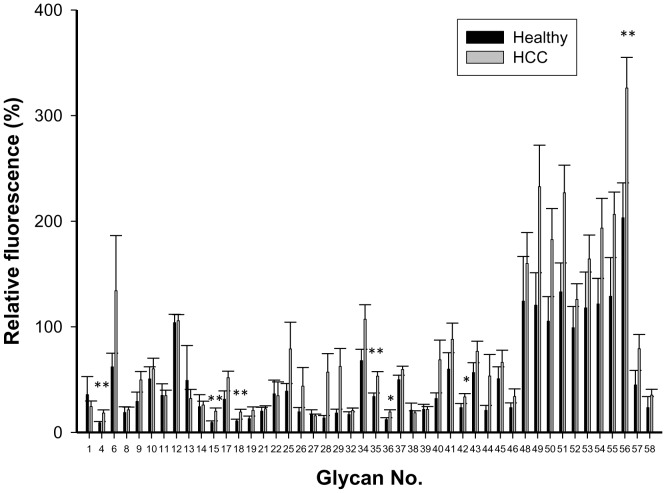
Ratio of anti-glycan IgG levels to anti-Gb5 levels in serum from healthy individuals and patients with HCC.Relative fluorescence ratios were calculated as the relative fluorescence intensity of each glycan analog divided by the relative fluorescence intensity of Gb5, and they are expressed as percentages in the figure. The figure shows the mean ratio ± standard deviation for each glycan. Asterisks indicate glycans in which the mean glycan:Gb5 IgG ratio was significantly higher in serum from patients with HCC (n = 155) than in serum from healthy individuals (n = 33). The p values were calculated with a Student’s t-test (*p<0.05; **p<0.01).